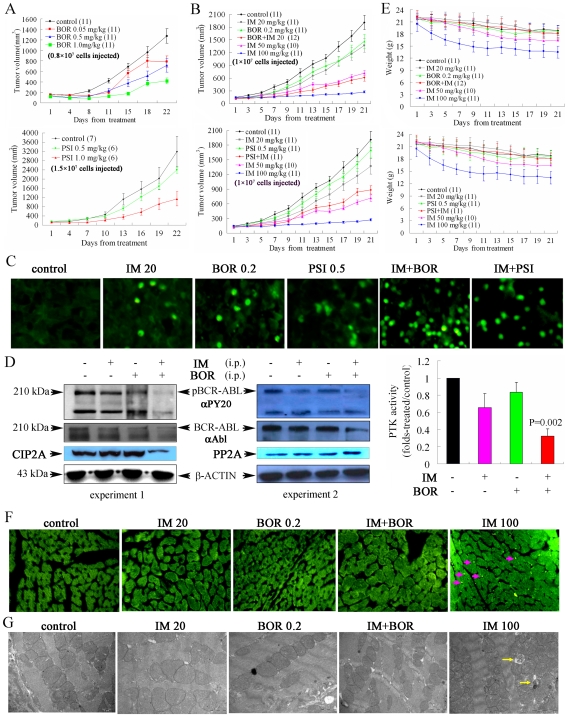
Antileukemia efficacy and side effects of IM/BOR and IM/PSI in nude mice inoculated with K562 cells.(A): K562 cells were injected under the skin of nude mice to establish xenotransplant tumors. Treatment with BOR (upper panel) or (lower panel) was begun when these tumors reached a volume of 120 mm3. The graph shows a quantification of tumor volumes at the indicated time points compared to the starting size. (B): IM/BOR (upper panel) and IM/PSI exert enhanced effects on inhibition of tumor growth in nude mice. (C): Mice were treated with indicated protocols, samples were obtained 1 h after the last drug injection, and TUNEL assay was performed. TUNEL-positive cells expressed as a percentage of the number of total cells, are shown in Figure S3. (D): Effects of IM/BOR and IM/PSI on pBCR-ABL, CIP2A, and PP2A in vivo. Left and middle panel, results of Western blot; Right panel, changes in BCR-ABL protein tyrosine kinase activity in tumor samples. P value inserted represents IM/BOR vs IM treatment group. i.p., injected intraperitoneally. (E): The graph shows the changes in body weight for mice treated protocols indicated. (F): Mice were treated with indicated protocols, sacrificed 1 h after the last drug injection, hearts sections were obtained, and TUNEL assay was performed. (G): Electron micrographs of hearts from mice treated with protocols indicated. Sarcoplasmic reticulum and vacuoles containing membrane whorls, vacuoles with membrane whorls within or immediately adjacent to mitochondria, and pleomorphic mitochondria, can be found in hearts of mice treated with IM at high dose but not IM/BOR-regimen.